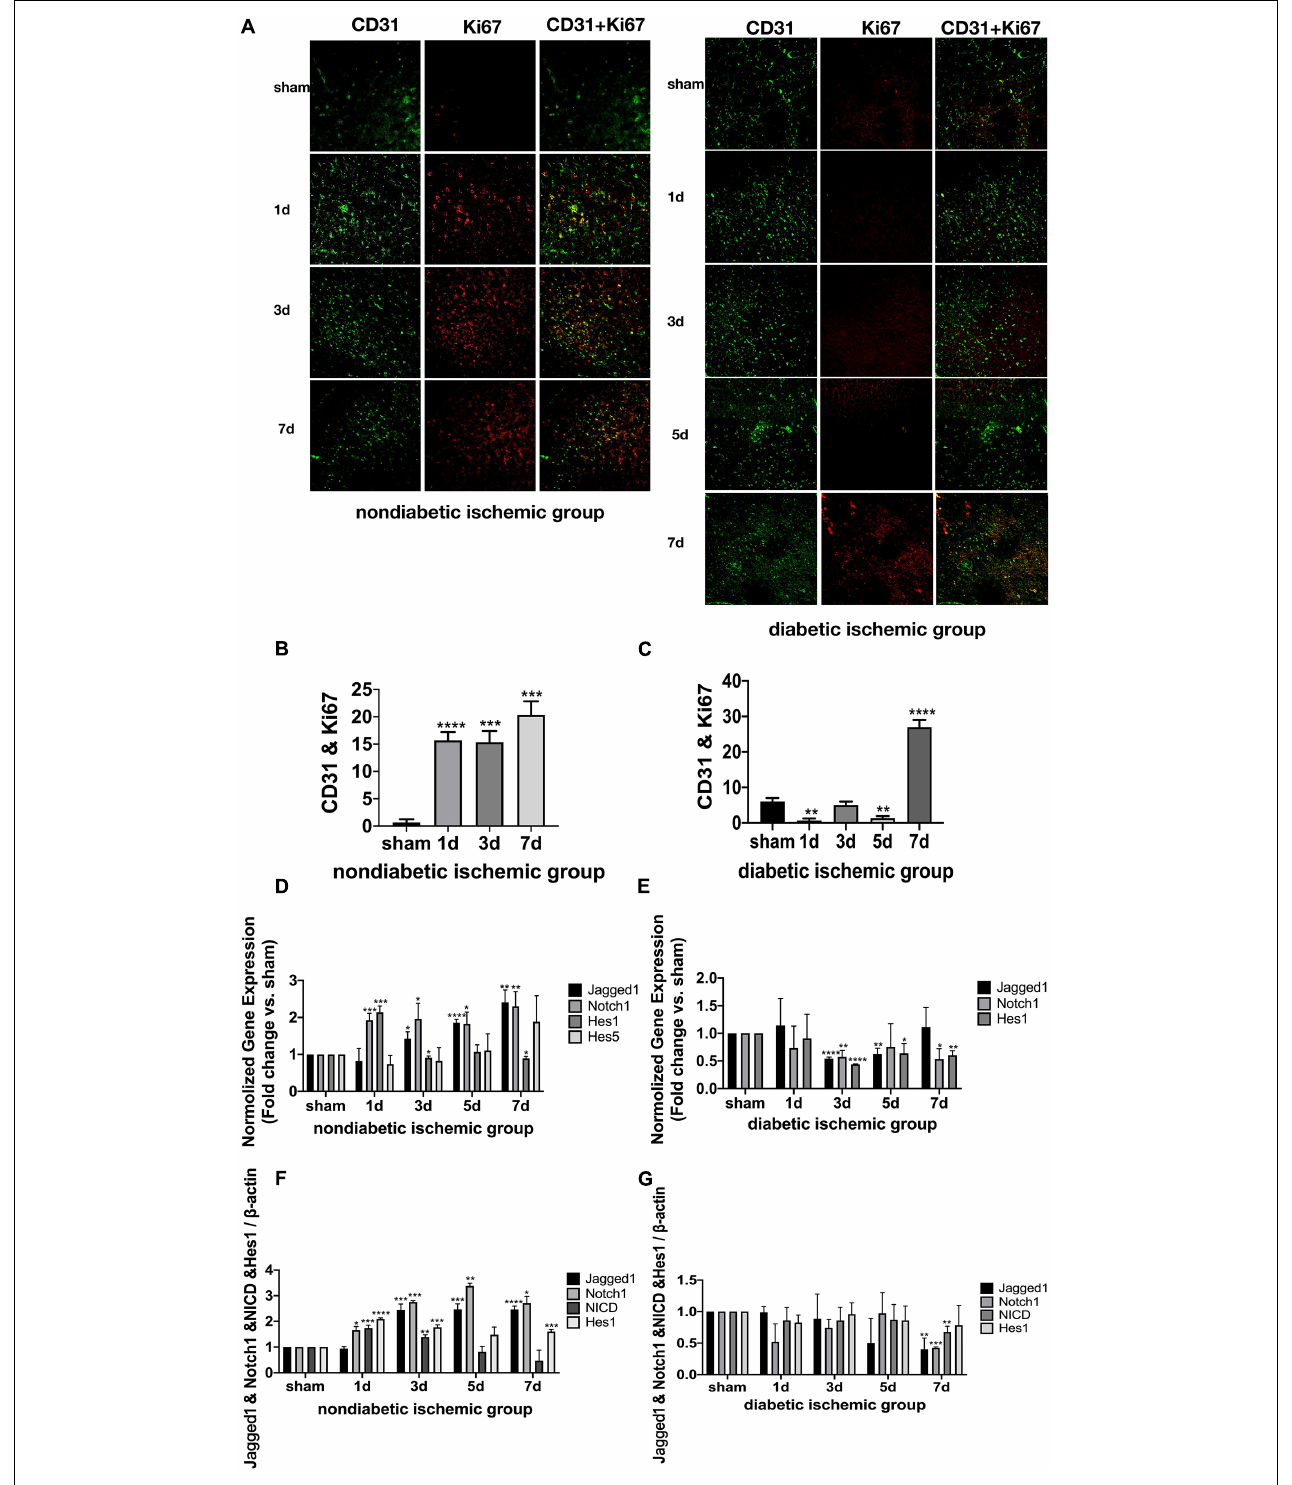
FIGURE 4 | Suppressed Jagged1-Notch1 signaling with hampered angiogenesis after acute ischemic stroke in T2DM. (A–C) The expression of Ki67 and CD31 was assessed by immunofluorescence staining in ischemic penumbra (Magnification * 200. Scale bar = 100 µ m) and the positive cells of Ki67 and CD31 were calculated ( n = 3 per group). (D,E) The gene expression of Jagged1, Notch1, Hes1, and Hes5 was showed in NDI and DI group. (F,G) The expression of Jagged1, Notch1, NICD, and Hes1 protein were calculated in NDI group and DI group. * p < 0.05 vs. sham group, ** p < 0.01 vs. sham group, *** p < 0.001 vs. sham group, **** p < 0.0001 vs. sham